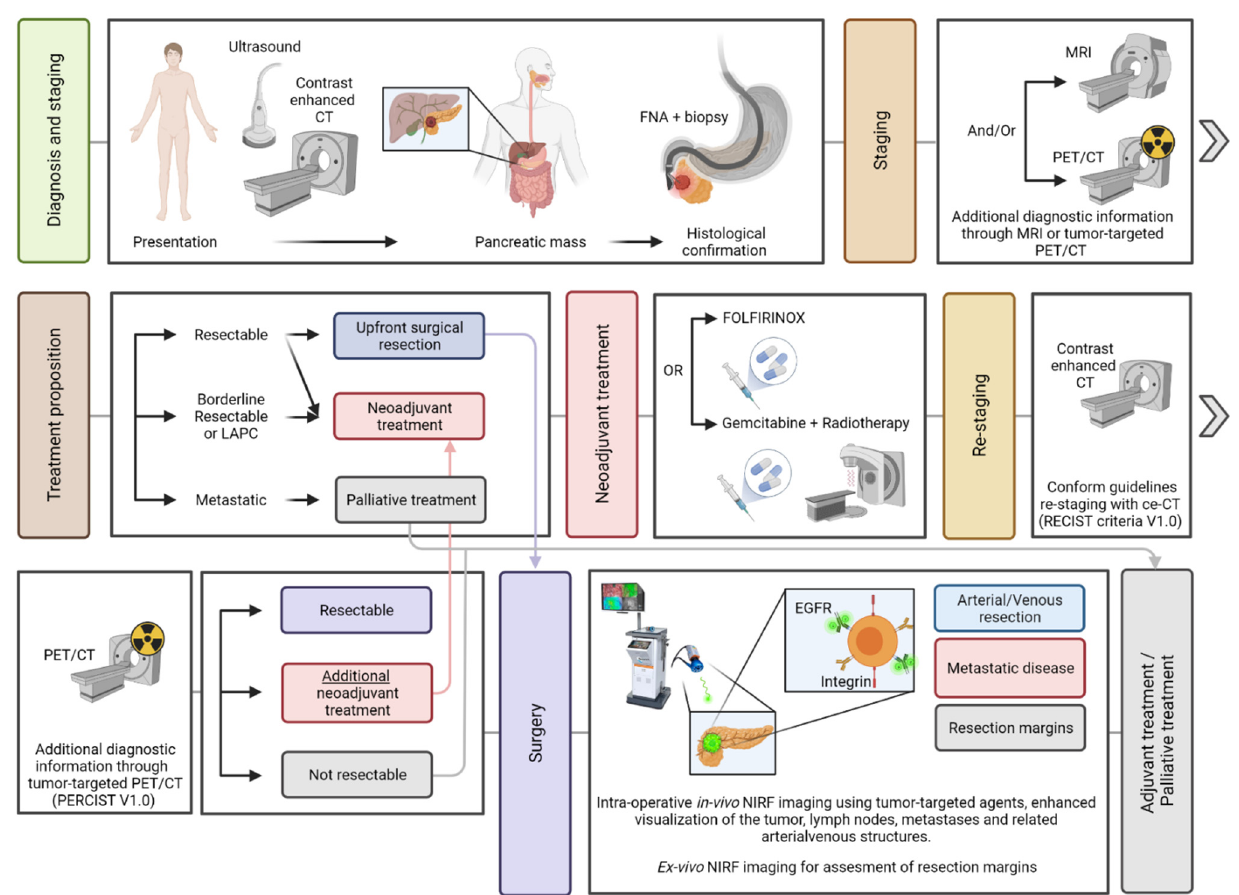
Figure 1. An overview is given of the patient journey from initial presentation to follow-up. Incorporation of molecular imaging in several stages of disease is presented. Abbreviations: CEA(CAM) = Carcinoembryonic antigen; EGFR = Epidermoid growth factor receptor; LAPC = Locally advanced pancreatic cancer; PDAC = Pancreatic ductal adenocarcinoma; RECIST = Response Evaluation Criteria in Solid Tumors; PERCIST = Positron Emission Tomography (PET) Response Criteria in Solid Tumors; NIRF = Near-Infrared Fluorescence Imaging. Created with BioRender.com.